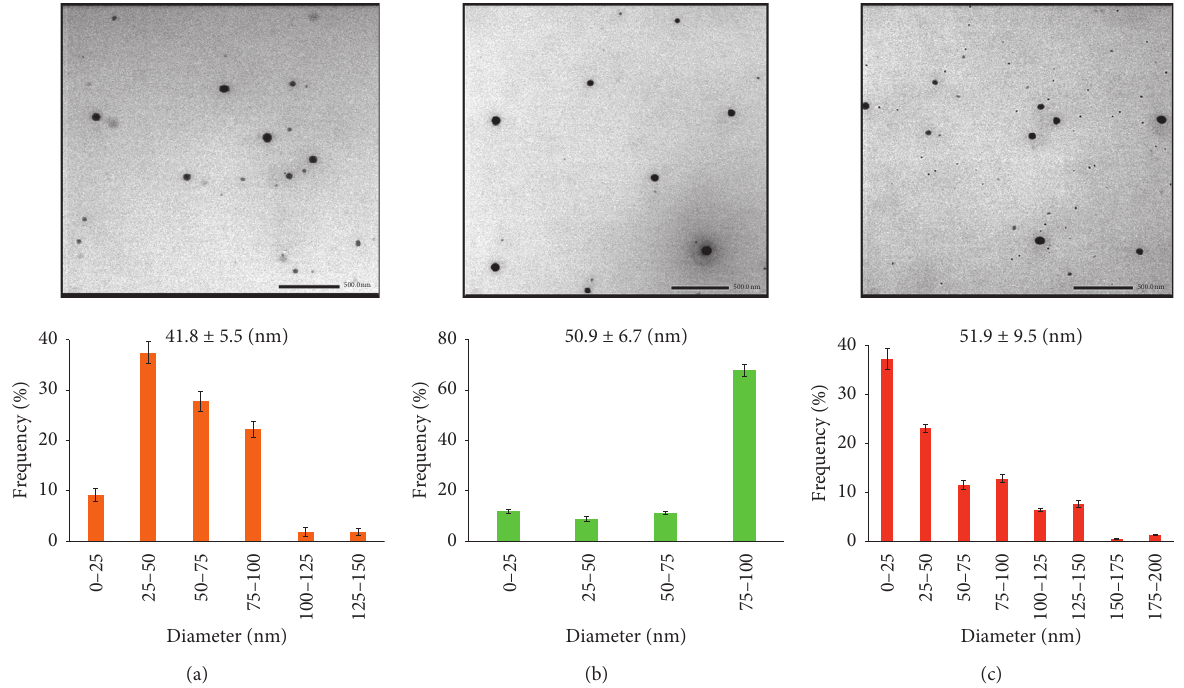
Figure 4: TEM image and size distribution of SeNPs/OCS stored at 4 ° C at different times: 0 days (a), 30 days (b), and 45 days